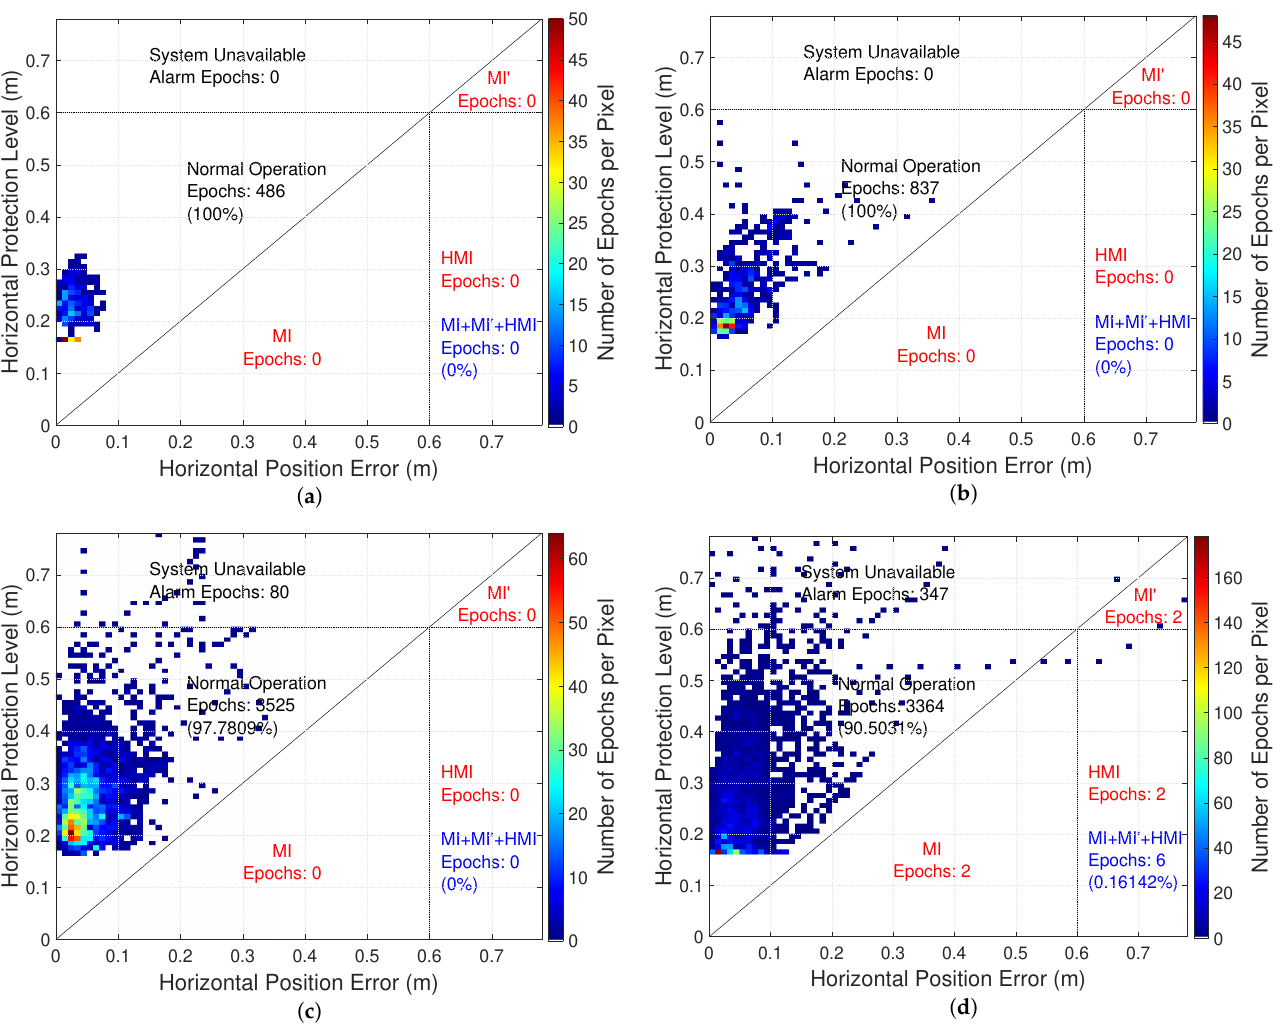
Figure 7. Stanford integrity diagrams for the protection level of the horizontal position error computed with chosen implementation of KIPL integrity algorithm in the four selected scenarios: ( a ) airfield, ( b ) highway, ( c ) country road and ( d )